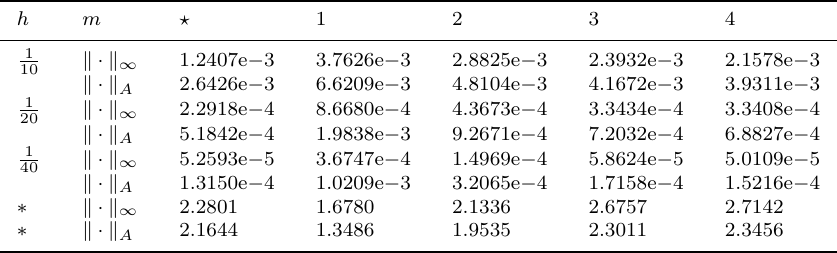
Table 2. Numerical results in the case a = 1 e − 3.